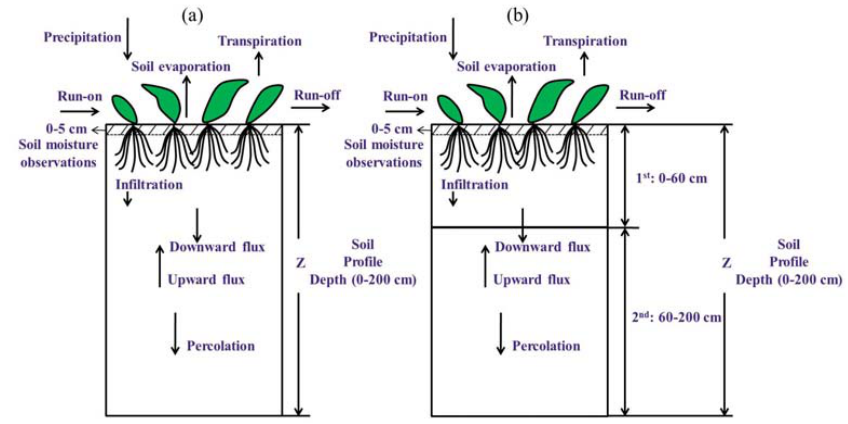
Figure 3. ( a ) Homogeneous soil column; ( b ) Layered (heterogeneous) soil